Question: Provide a publication-style caption for this figure.
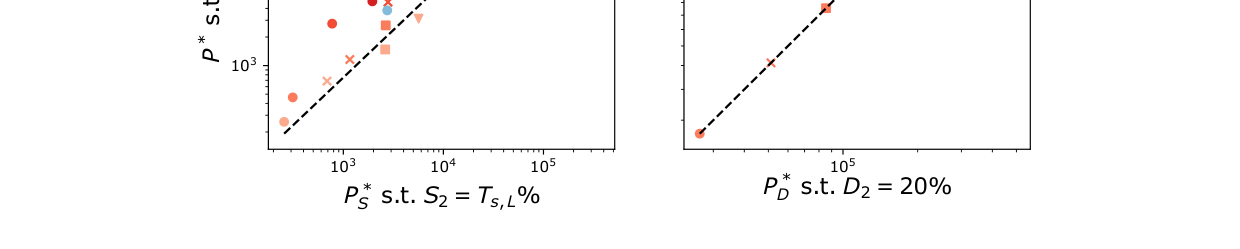
Answer: CNN. Left panels: empirical sample complexity P ∗ S to reach S2 = Ts,L% (with the threshold Ts,L = 40 if L = 2 and s = 2, 50 if L = 2 and s = 3, 20 if L = 3) versus empirical sample complexity P ∗to reach a 10% test error ε for (Top) s = 2 and (Bottom) s = 3, for different depths L (red for L = 2, blue for L = 3) vocabulary sizes v (different darkness), maximal m = vs−1 and different s0 (different markers). Right panels: same as left panels, but with the sample complexity P ∗ D to reach D2 = 20%. Both P ∗ S and P ∗ D align with P ∗. The thresholds have been tuned based on the form of S2 and D2 versus P.